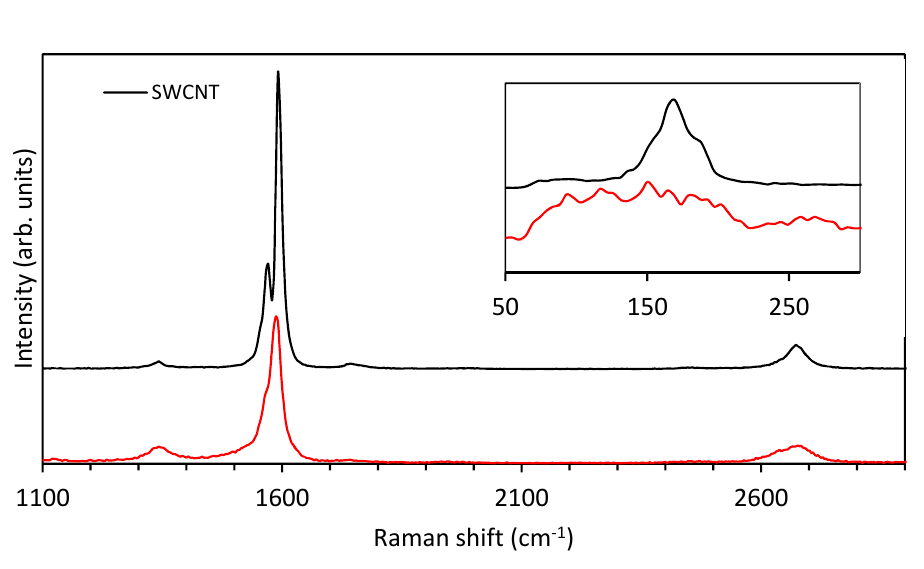
Figure 1. Raman spectra for a single-walled carbon nanotube (SWCNT) and a double-walled carbon nanotube (DWCNT) with inset showing the radial breathing mode (RBM) region.